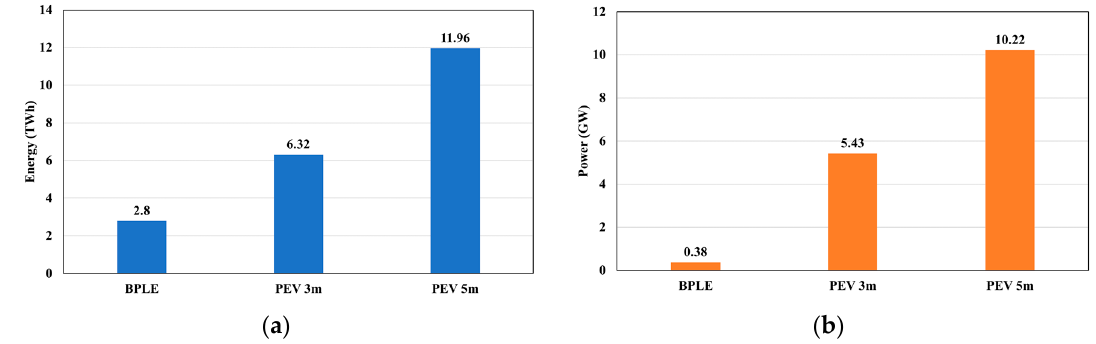
Figure 14. Comparing results with 8th BPLE; ( a ) Charging energy; ( b ) Maximum charging power.